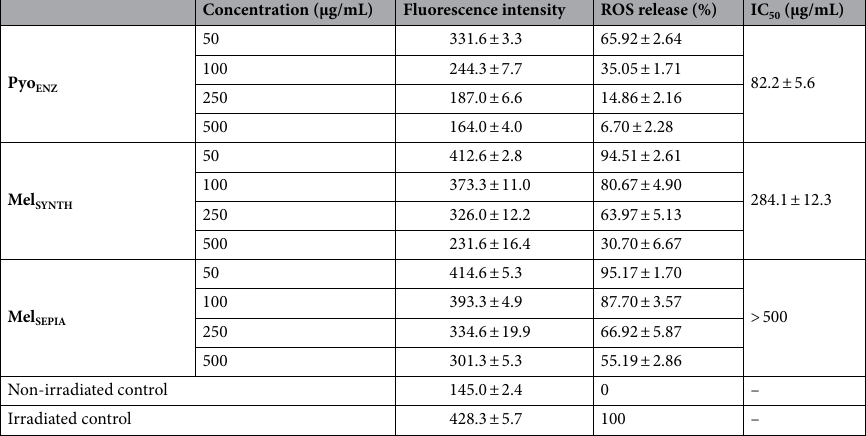
Table 3. Effect of Pyo ENZ on scavenging ROS generated by UVA irradiation on keratinocyte cells. The ROS release was detected by fluorometric measurement and inhibition of the DCFH-DA reagent. Pyo ENZ antiradical activity was compared to that of the melanin standards. Determinations resulted from triplicate assays and IC 50 values were calculated by the Phototox v2.0 software (ZEBET, Germany). Experimentally, keratinocyte cells (see phototoxicity protocol for preparation) were UVA-irradiated in presence of grads concentration (50–500 μg/mL) of Pyo ENZ and standard melanin (Mel SYNTH , Mel SEPIA ), or not (control). Cells were decanted, washed twice by a 25 mM PBS buffer at pH 7.4, then loaded with 2 ′ ,7 ′ -dichlorofluorescein- diacetate (DCFH-DA) to a final concentration of 20 μM, and incubated in dark at 37 °C for 30 min. ROS were then measured by fluorescence intensity of dichlorofluorescein (DCF) at an excitation wavelength of 499 nm and an emission wavelength of 521 nm, in an Infinite M200 Pro fluorescence reader (TECAN, Swiss) equipped with a 1-cm quartz cell. Irradiation was carried out with the Suntest CPS + solar simulator (xenon arc lamp 1100 W, with filters to restrict light transmission below 290 nm and near IR), at a dose of UVA-visible light of 138 kJ/m 2 , the irradiance was at 765 W/m 2 and irradiation time 3 min. The temperature of the samples was maintained at 4 °C using a water-cooling system linked to the irradiation chamber. Inhibition of DCFH-DA fluorescence (Fluo) was expressed as a percentage as compared to the irradiated and non-irradiated control (without pyomelanin or melanin): ROS release (%) = 100 × (Fluo test − Fluo -irr control )/(Fluo +irr control − Fluo -irr control ). IC 50 (μg/mL) values were calculated by the Phototox v2.0